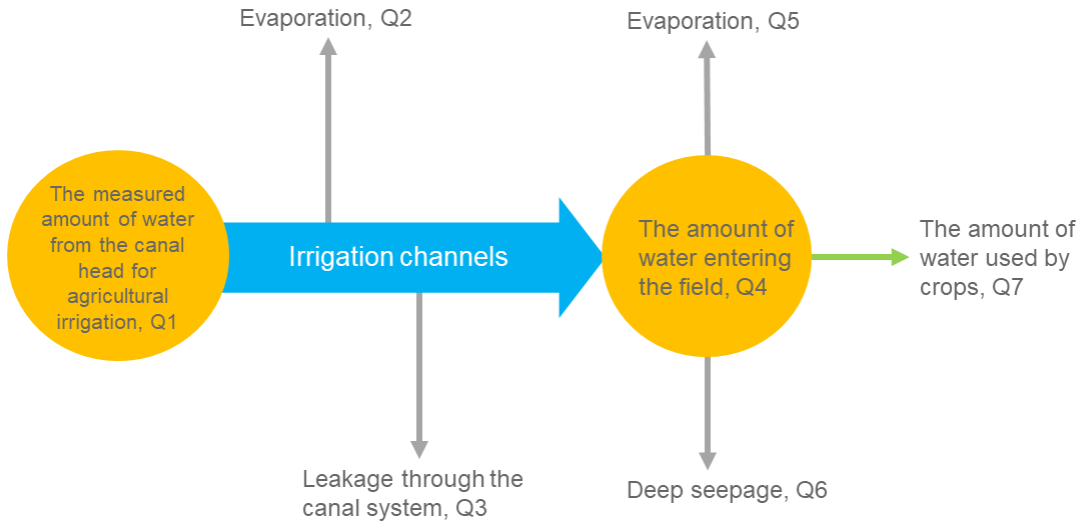
Figure 2. The water path of irrigation system in the study area.